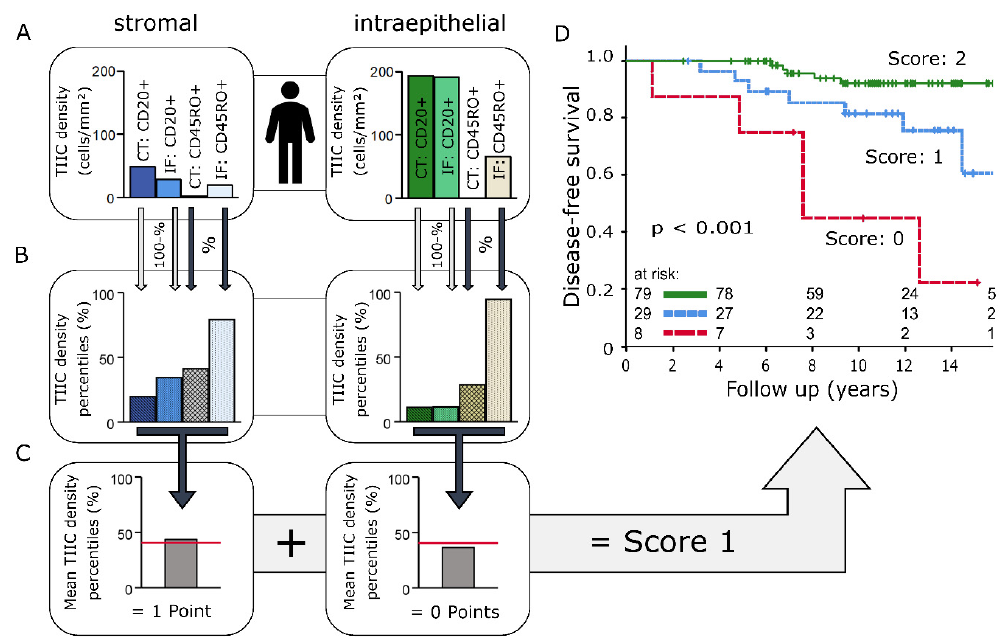
Figure 5. ( A – C ): Immunoscore model applied to results of one patient: ( A ) Observed stromal and intraepithelial CD20+ and CD45RO+ tumour-infiltrating inflammatory cell (TIIC) densities in central tumour (CT) and invasive front (IF) samples. ( B ) CD45RO+ TIIC densities ranked as percentiles within the whole cohort. CD20+ TIIC density percentiles were subtracted from 100 due to the negative prognostic effect of CD20+ TIICs. ( C ) Mean TIIC percentiles of the stromal and intraepithelial compartment. Mean percentiles above the threshold (red line) resulted in one immunoscore point per compartment. ( D ) Disease-free survival analysed with the Kaplan–Meier method and log-rank test according to immunoscore results based on stromal and intraepithelial CD20+ and CD45RO+ TIIC densities.